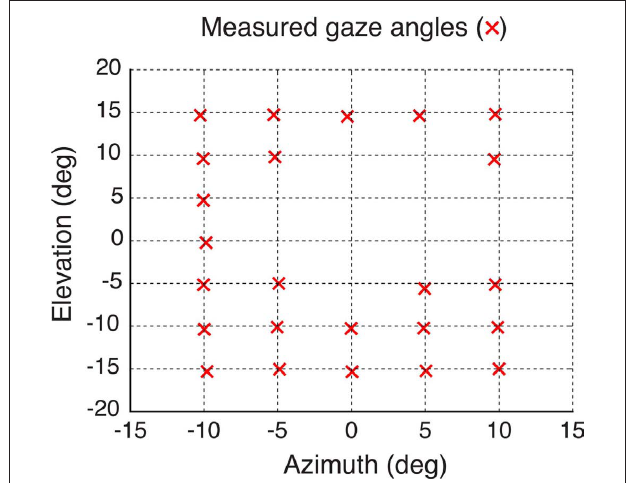
Figure 7 | Validation of the eye-tracking system using an artificial eye. The artificial eye was rotated to a grid of known azimuth and elevation angles (intersections of the dashed lines) while the pupil on its surface was tracked. Pupil gaze measurements were repeated 10 times and their average values were drawn (red crosses) superimposed over the grid of know gaze angles to show the accuracy of the eye-tracking system. Missing measurements (i.e., grid intersections with no red crosses) refer to pupil rotations that brought the LED infrared source to shine directly onto the opaque simulated pupil, resulting in a missing CR spot (see Materials and